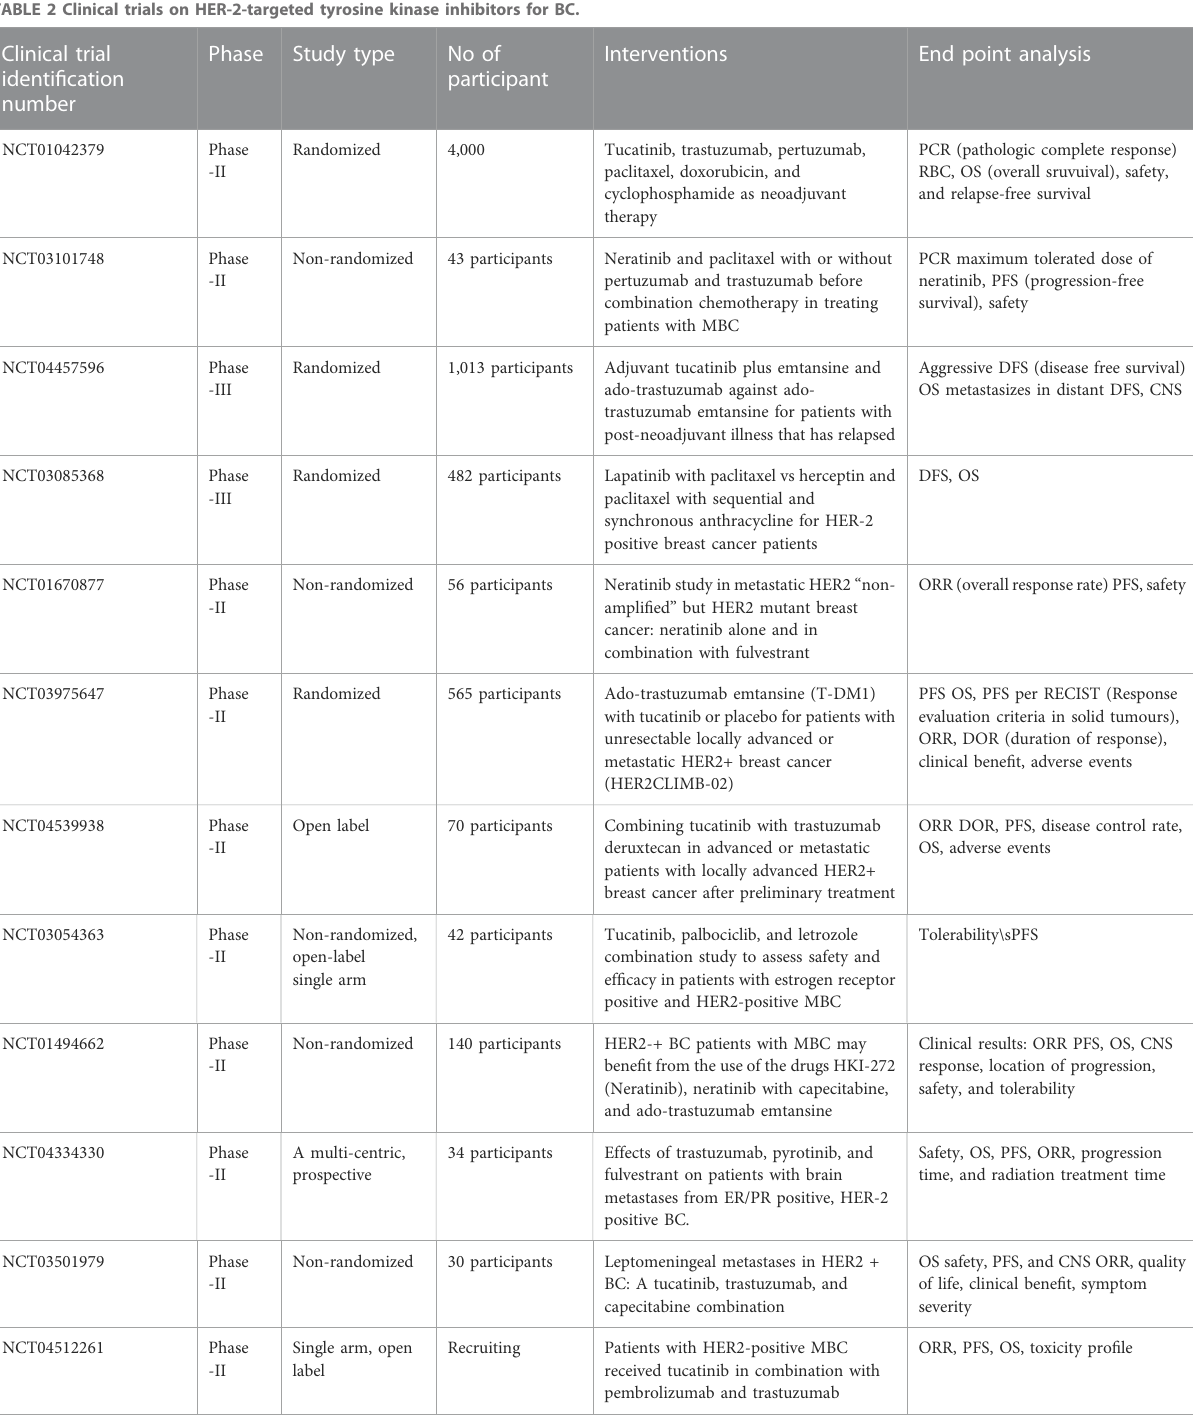
TABLE 2 Clinical trials on HER-2-targeted tyrosine kinase inhibitors for BC. Clinical trial identi fi